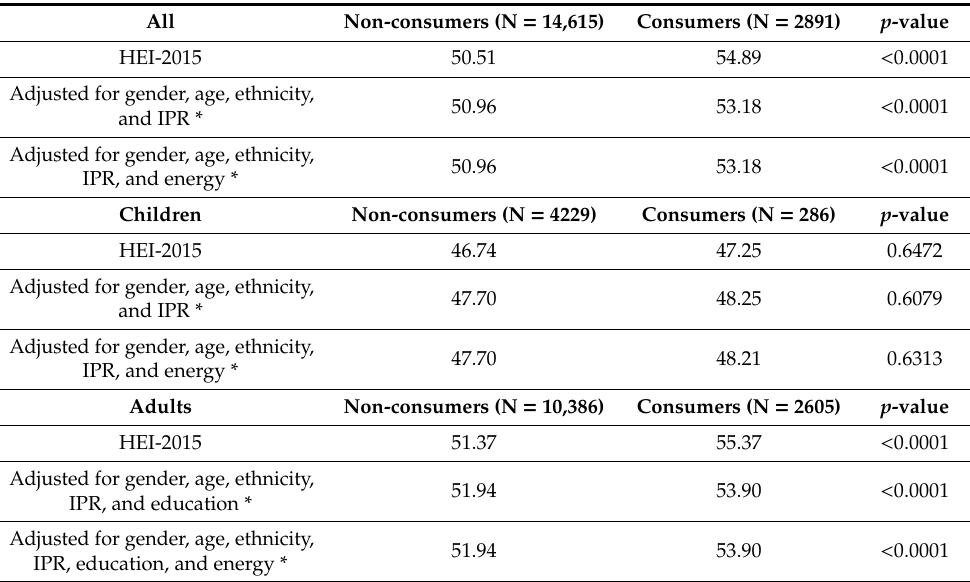
Table 4. Healthy Eating Index (HEI-2015) diet quality scores for tea consumers and non- consumers for children and adults. Univariate and adjusted models are